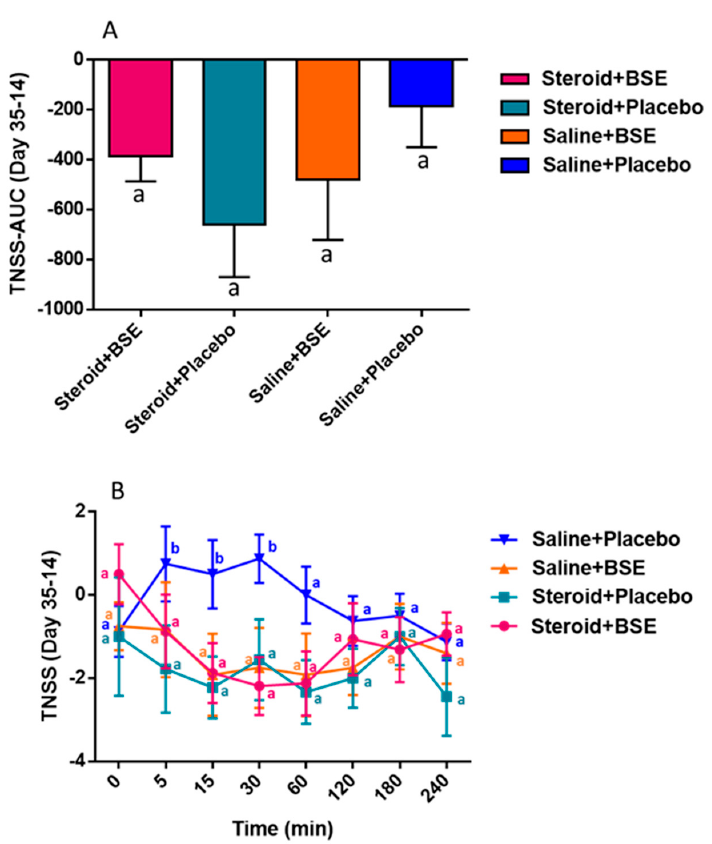
Figure 3. Differences between before intervention (day 14) and after intervention (day 35) for total nasal symptoms score (TNSS) were recorded. AUC was calculated for TNSS among the 4 groups, showing a mean of − 0.5277 (sd 0.1048) in group 1, − 0.8359 (sd. 0.3903) in group 2, − 0.5484 (sd.